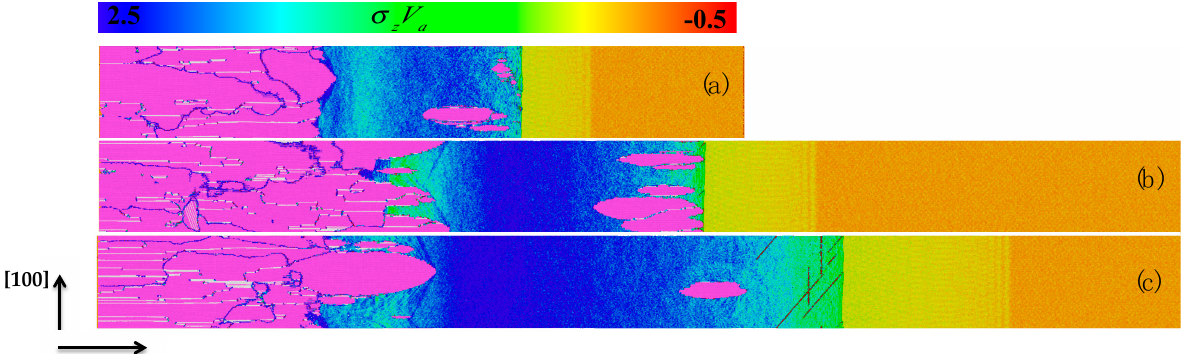
Figure 1. Snapshots of the atom configurations at times 33 ps ( a ), 48 ps ( b ), and 60 ps ( c ) under ramp compression rise times of 30 ps ( a ), 45 ps ( b ), and 60 ps ( c ). The bcc atoms are colored according to their σ z Va value, where Va is the atomic volume, and σ z is the stress component along the wave propagation z-axis. The hcp and fcc atoms, detected by the adaptative CNA analysis, are colored in magenta and white, while twins (detected by centrosymmetry analysis) are colored in brown (regardless of the stress). A double nucleation front of the hcp phase (violet) can be observed since the transformation occurs (i) at the top of the pressure ramp propagating from left to right and (ii) where the ramp wave steepens into a shock (see text for more details). Note that a longer ramp rise time requires longer propagation distance. Thus, the sample length in the wave propagation direction was 800 a 0 for ( a ), while it was 1400 a 0 for both ( b ) and ( c ).